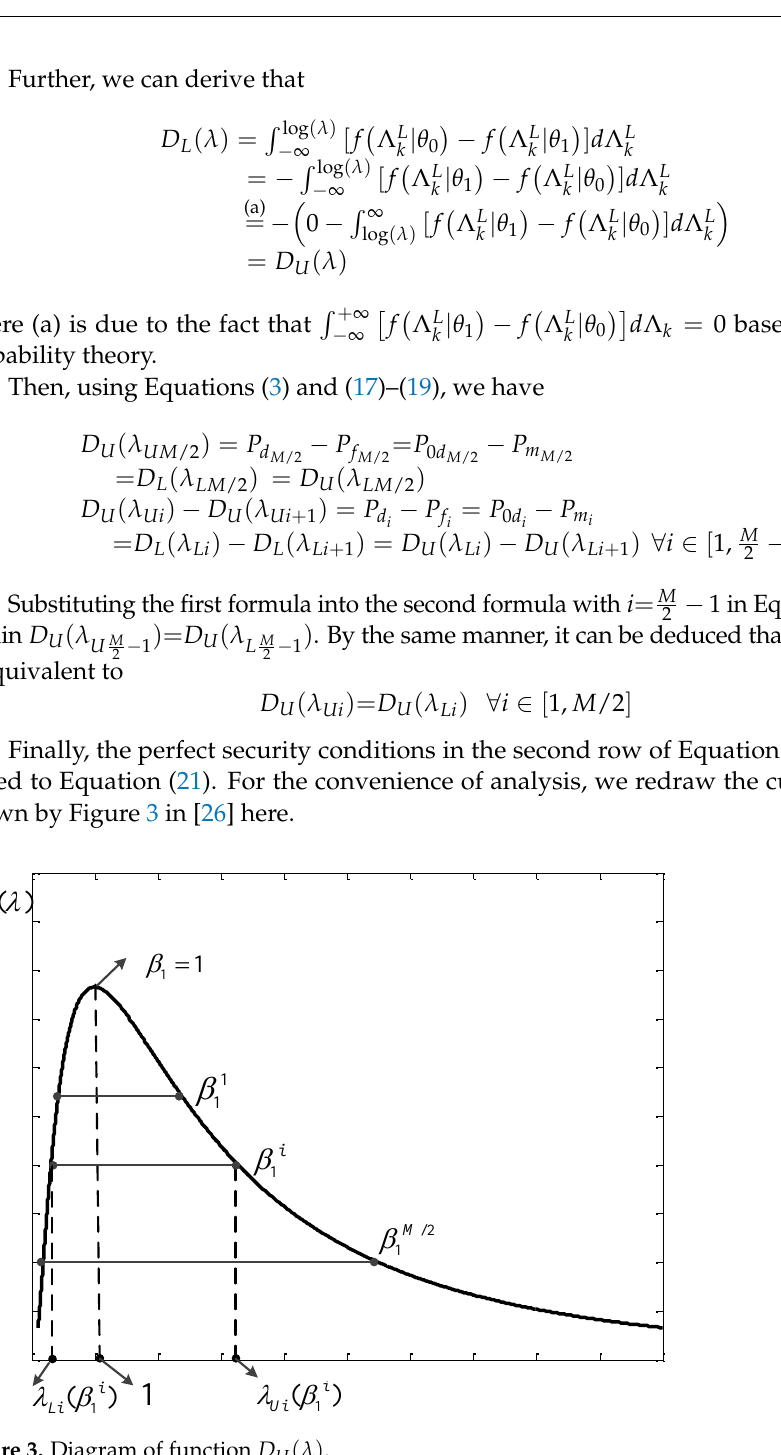
Figure 3. Diagram of function D U ( λ )